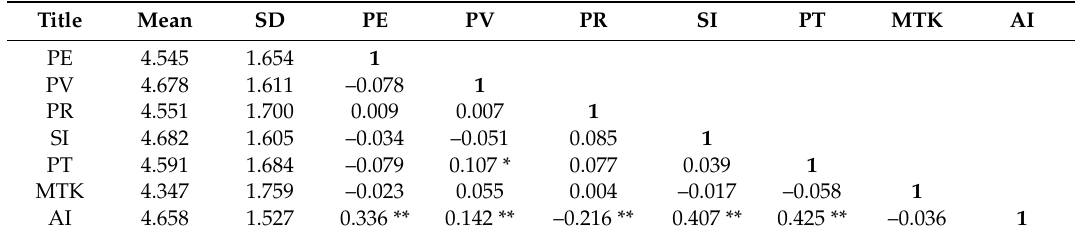
Table 4. Correlation